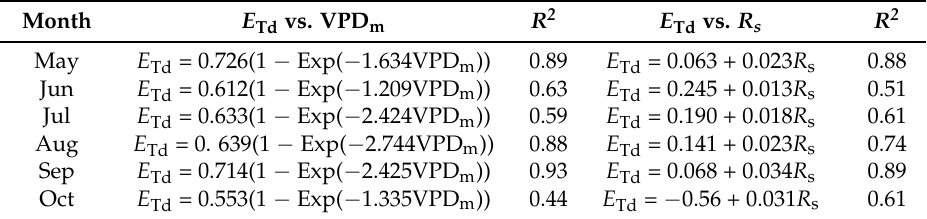
Table 2. Fitted equations for daily stand transpiration ( E Td ) with mean daytime vapor pressure deficit (VPD m ) and total solar radiation ( R s ) for each month during the growing season of 2009.